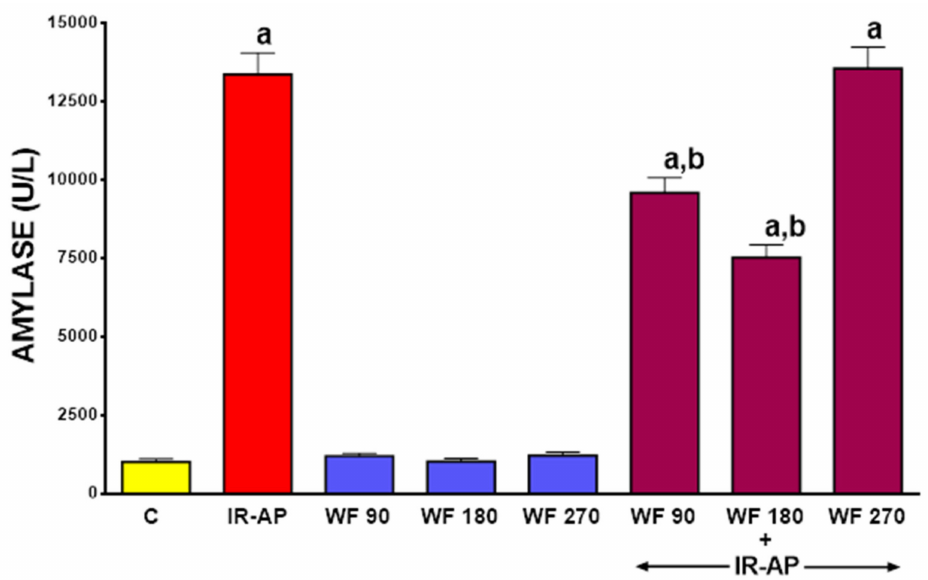
Figure 3. Impact of ischemia / reperfusion-induced acute pancreatitis (IR-AP) or / and pretreatment with warfarin given at a dose of 90, 180 or 270 µ g / kg / dose (WF 90, WF 180 or WF 270) on serum amylase activity. Mean ± SEM. n = 10 animals in each experimental group. a p < 0.05 compared to control (C), b p < 0.05 compared to